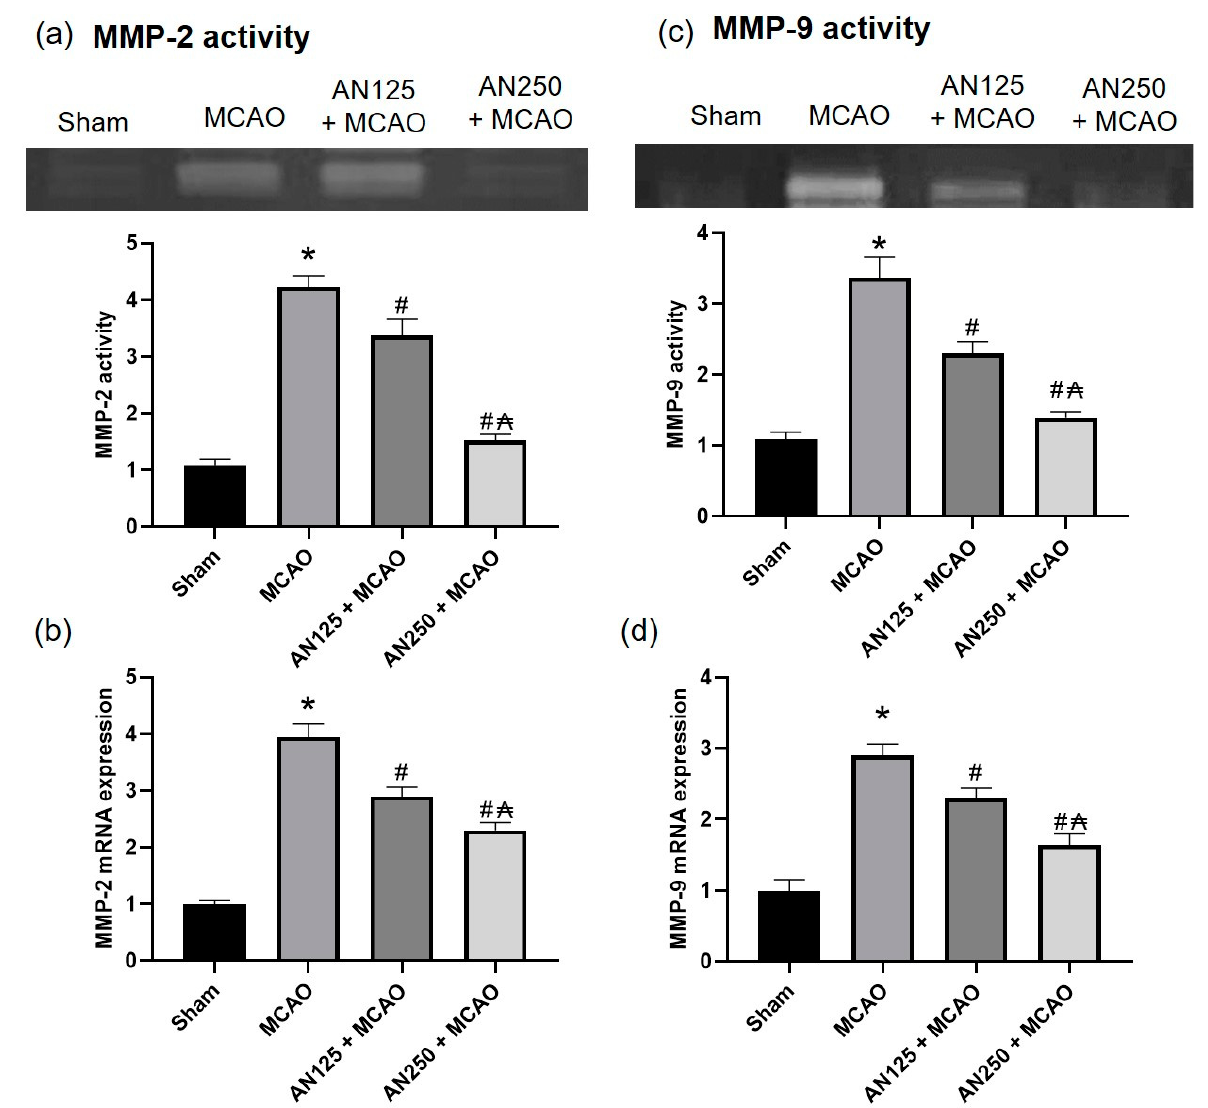
Figure 1. The impact of pretreatment with anethole (AN, 125 and 250 mg/kg, orally) for two weeks in MCAO-induced cerebral ischemia/reperfusion on ( a ) infarct volume, ( b ) neurological deficits, ( c ) Evans blue concentration and ( d ) brain water content percentage. Data are expressed as mean ± SD ( n = 6). * significantly different from the sham-operated group, # significantly different from the MCAO ischemic group, and ₳ significantly different from the AN125 + MCAO group at p < 0.05 using ANOVA followed by Tukey’s post hoc test.